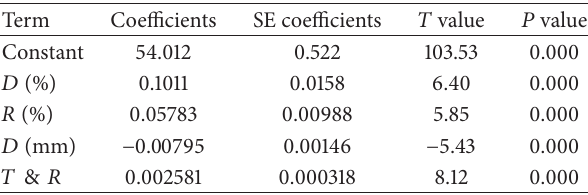
Table 5: Regression coefficients